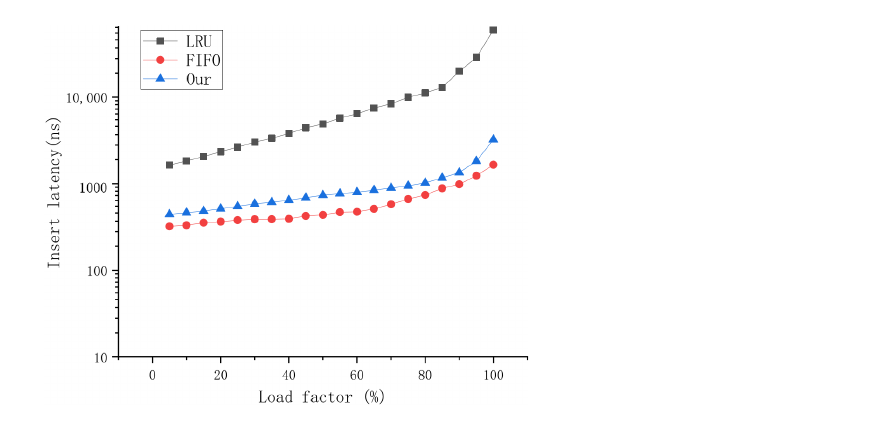
Figure 9. Insert latency of different cache replacement algorithms under different load factors in the eight-core.